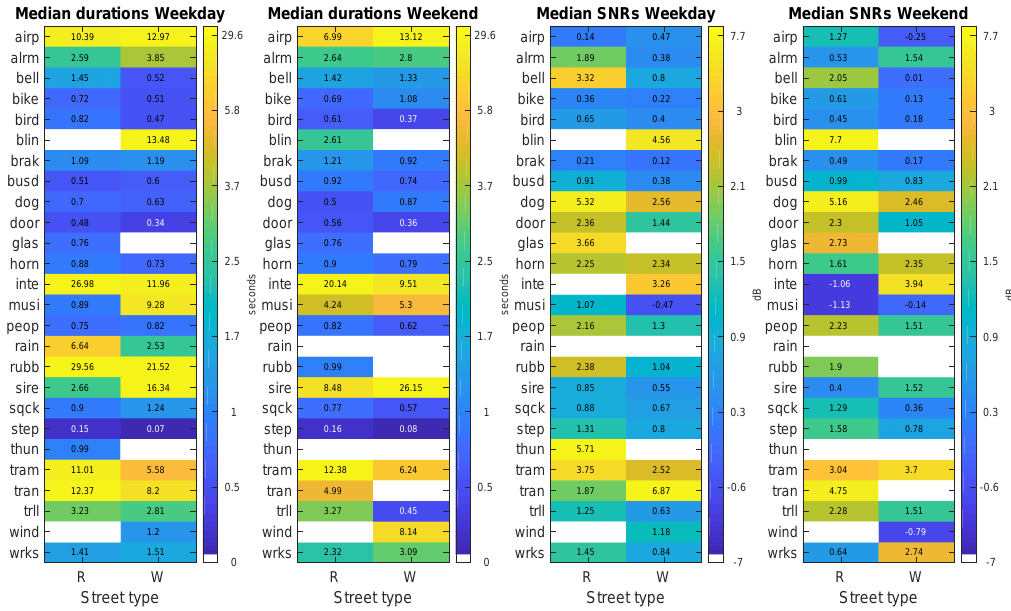
Figure 7. Results of the narrow–wide analysis ( P RW matrices) differentiating weekday and weekend days for the following ANE features: median duration (two leftmost subfigures) and median SNR (two rightmost figures). Each subfigure shows the distribution of the corresponding ANE feature in terms of ANE subcategory and type of street where the sensor is